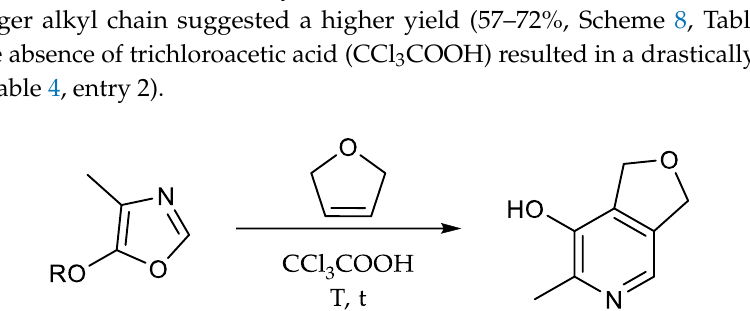
Table 3. Reaction conditions for the cyclisation of 5-alkoxy-4-methyl-oxazoles.